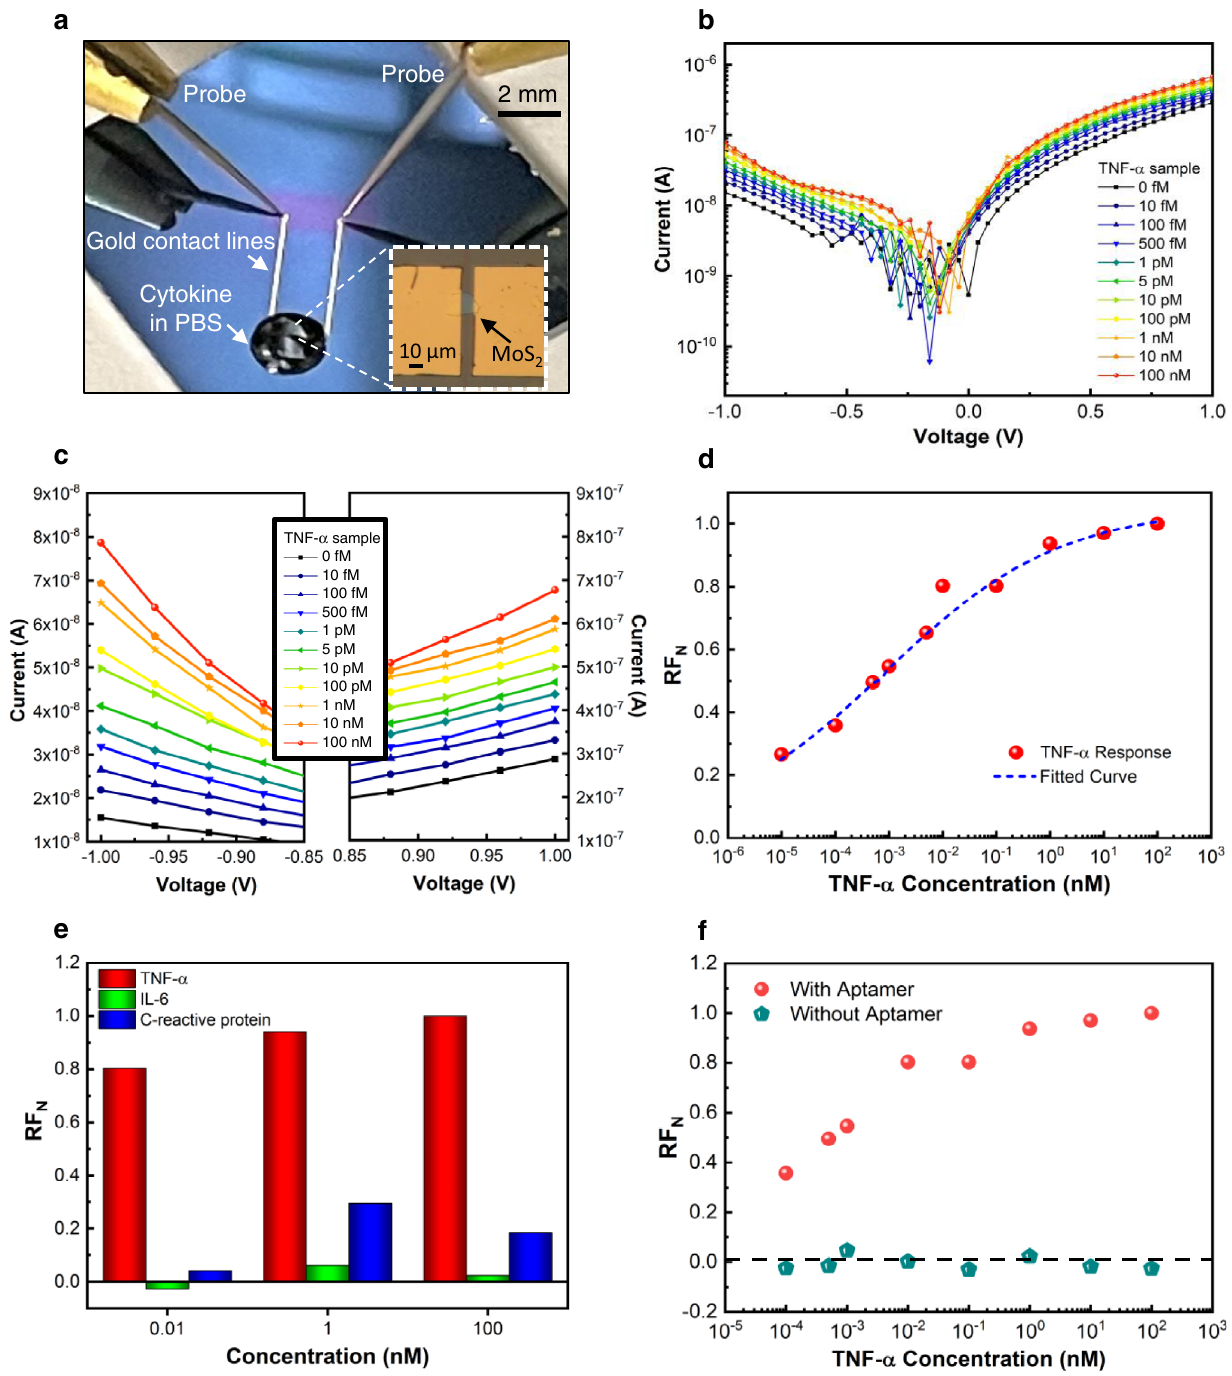
Fig. 3 | Performanceofthe sensor. a Anoptical image of the TNF- α measurement setupwherethesensingmaterial,MoS 2 ,iscontactedbyelectricalprobes.Theinset shows an optical micrograph of the device sensing area while coated by a drop of TNF- α in phosphate-buffered saline (PBS). I – V response of the MoS 2 diode as a function of TNF- α cytokine concentration in b log scale, and c linear scale with a